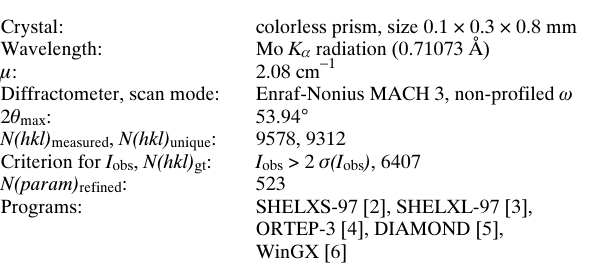
Table 1. Data collection and